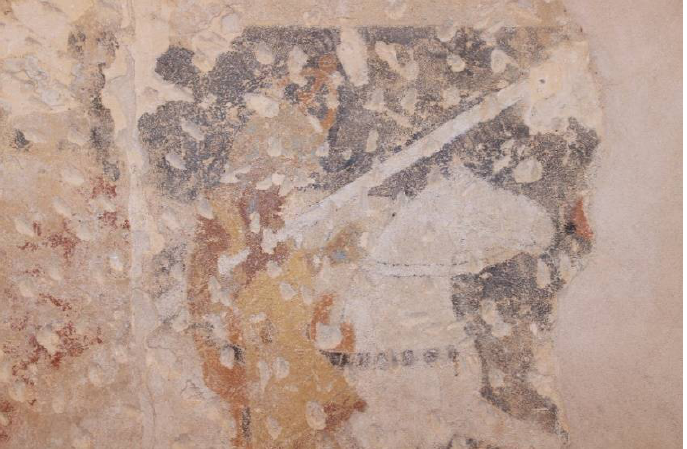
Figure 21. Kunštát, castle. The northern wall of the room with the knight’s cycle, detail of a knight with anchor in the coat of arms—probably Gahmuret, the father of Parsifal. First half of the 14th century. Photo by František Záruba, the author’s own work.